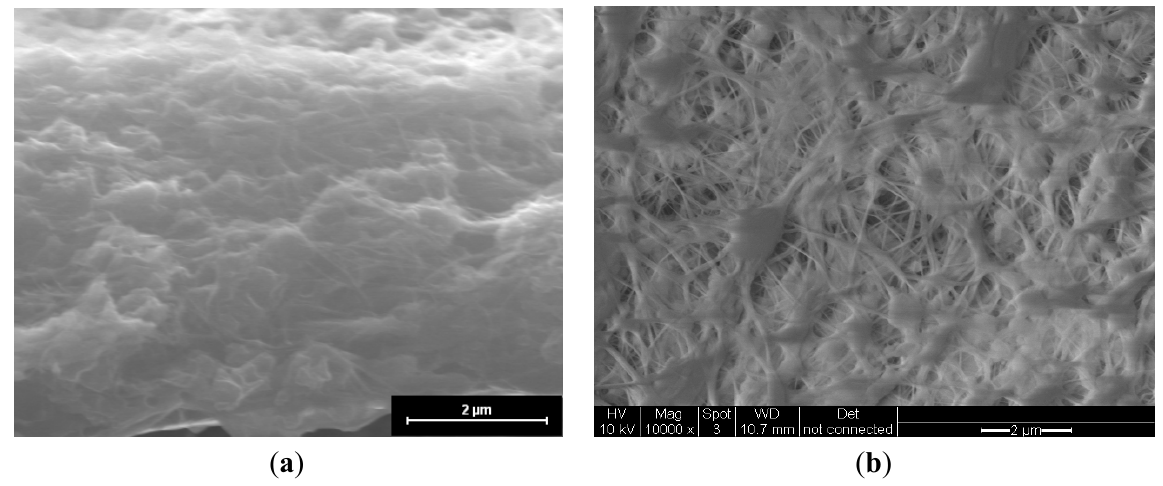
PO composite membrane; and ( b ) PTFE. 3 4